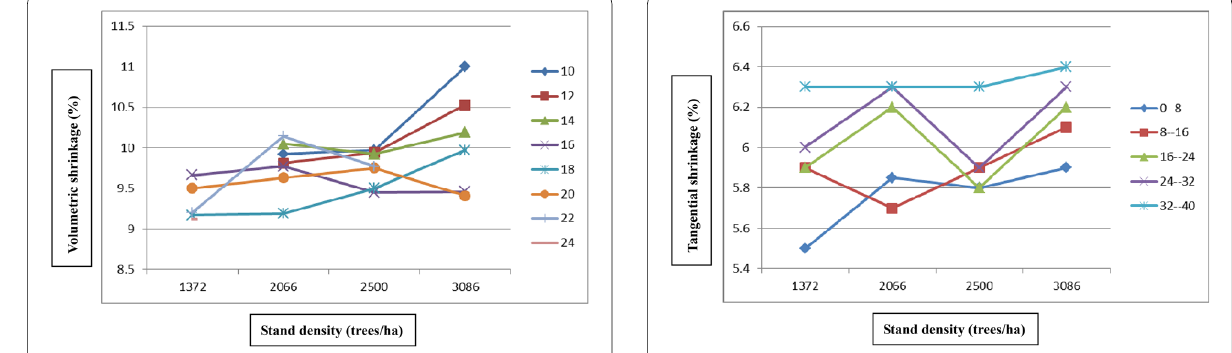
Fig. 8 Tangential shrinkage in relation to log height and stand density